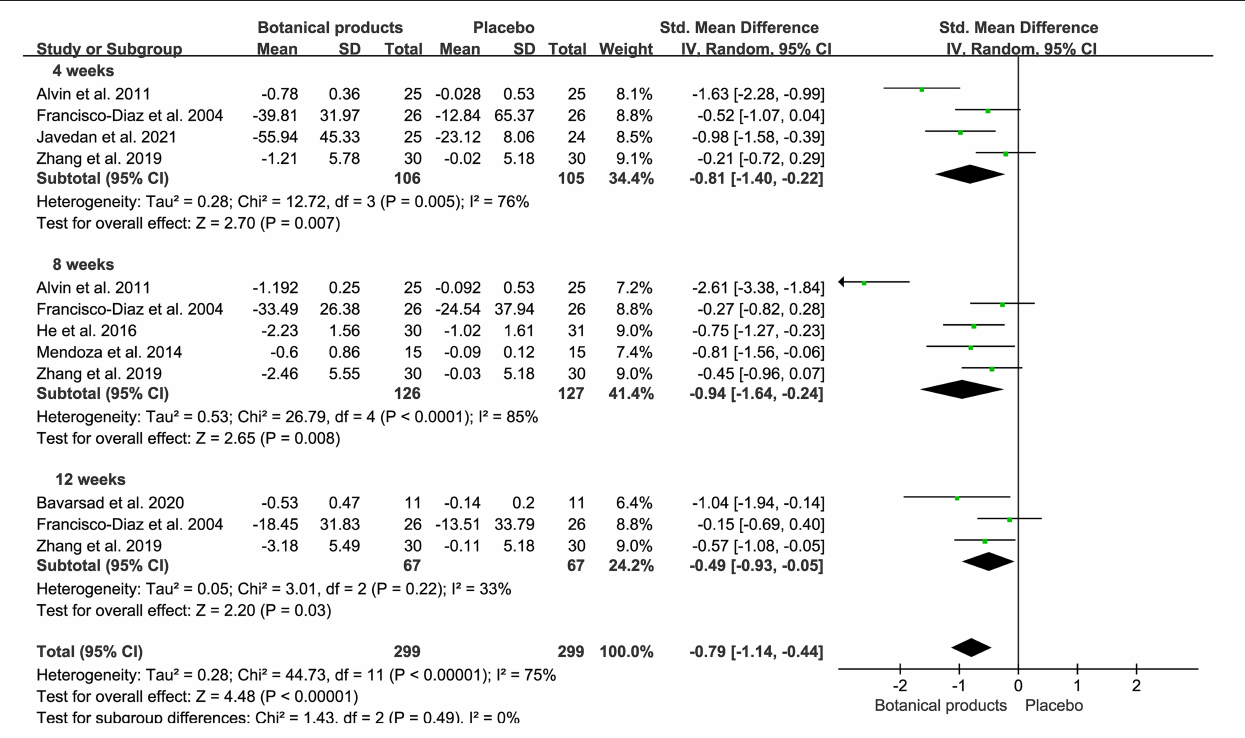
FIGURE 3 | Forest plots depicting the standardized mean difference (SMD) of Melasma Area and Severity Index (MASI) reduction in patients with melasma receiving botanical products in placebo-controlled trials. Subgroup analysis was stratified according to the duration of the intervention.